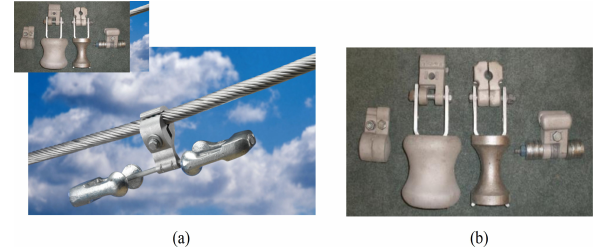
Figure 3: The novel Stockbridge damper ing (a) and